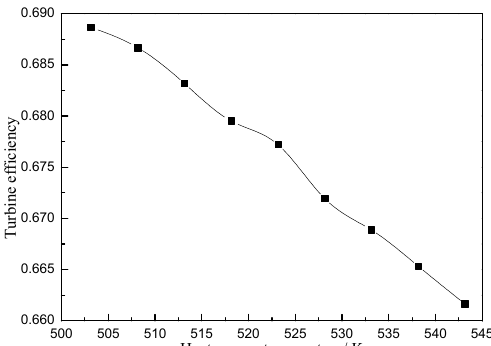
Figure 12. Optimal condensation temperature at different heat source temperature.